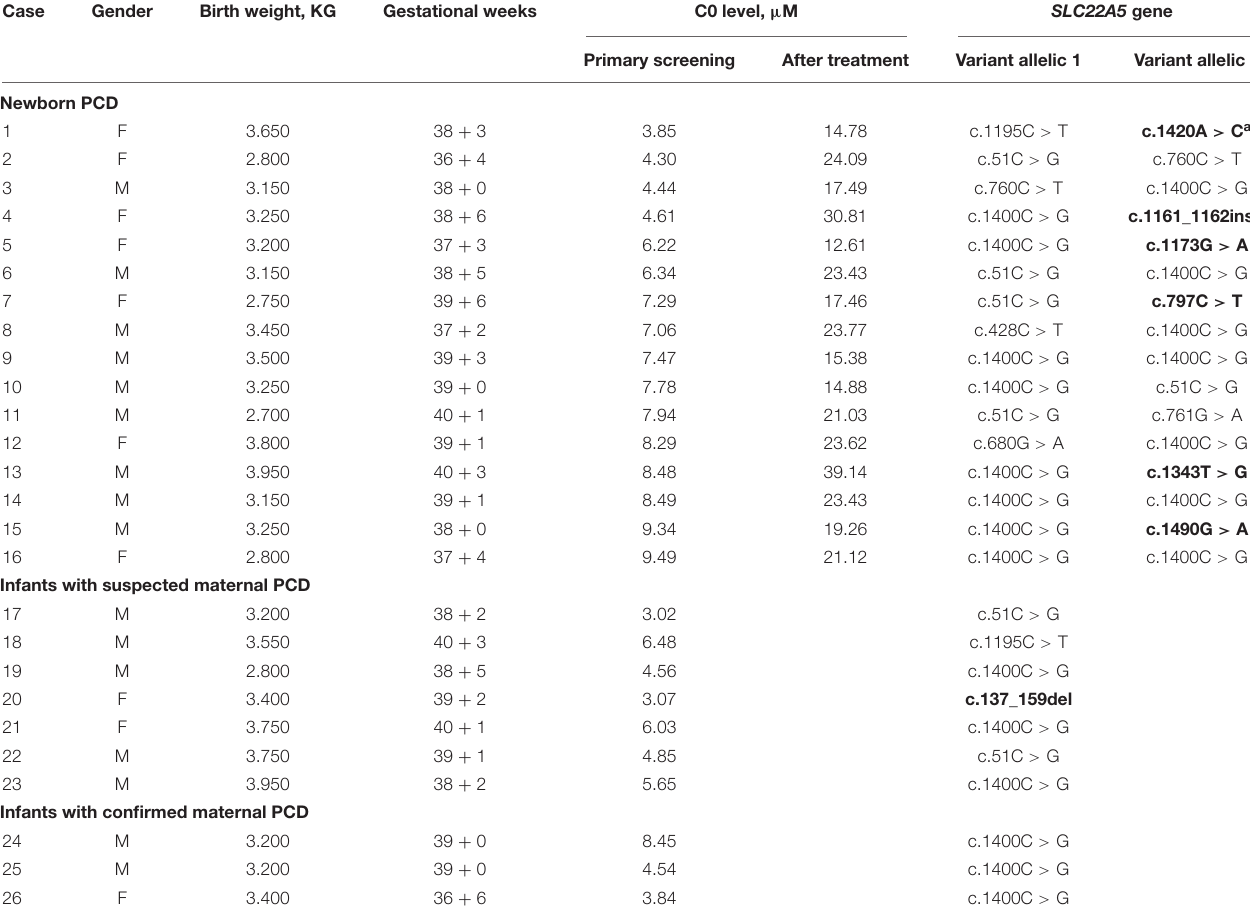
TABLE 3 | Clinical and genetic characteristics of the SLC22A5 variants.